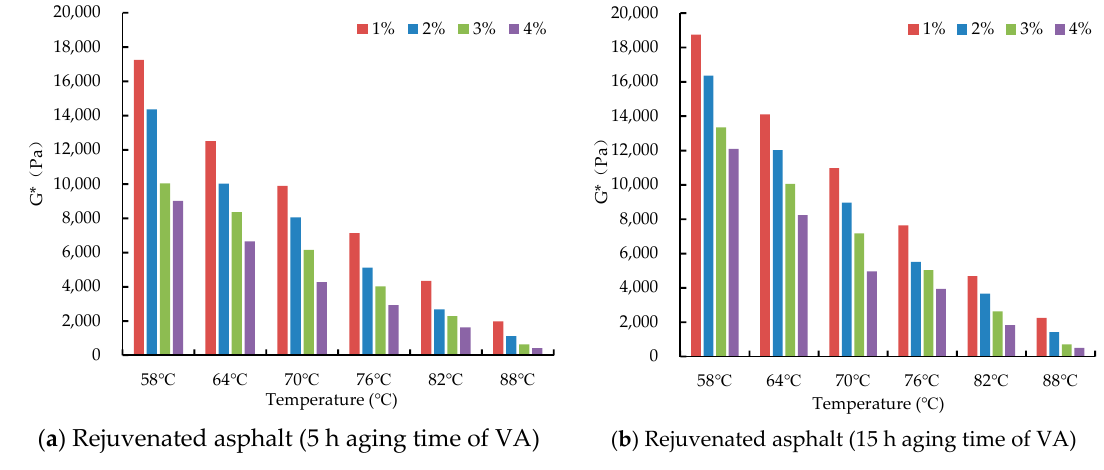
Figure 14. Effects of WCO on complex modulus of rejuvenated asphalt (different aging time of VA).